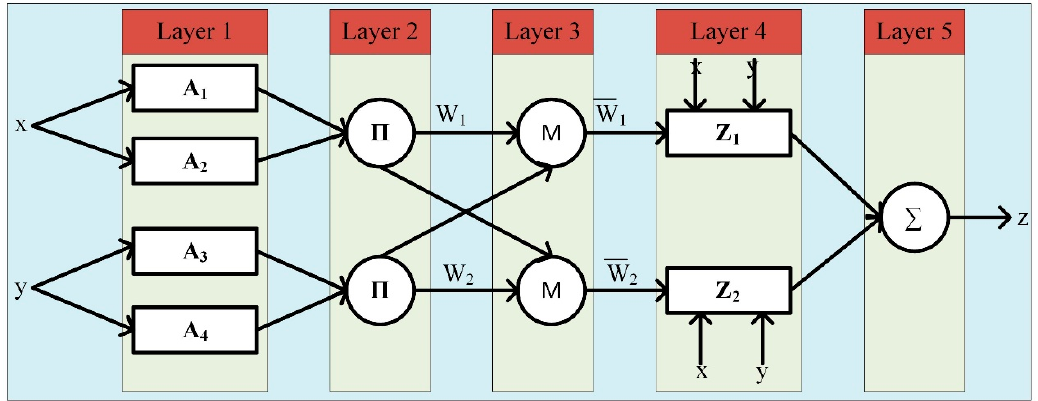
Figure 1. The architecture of the adaptive neural network-based fuzzy inference system (ANFIS) with type-3 reasoning mechanisms.